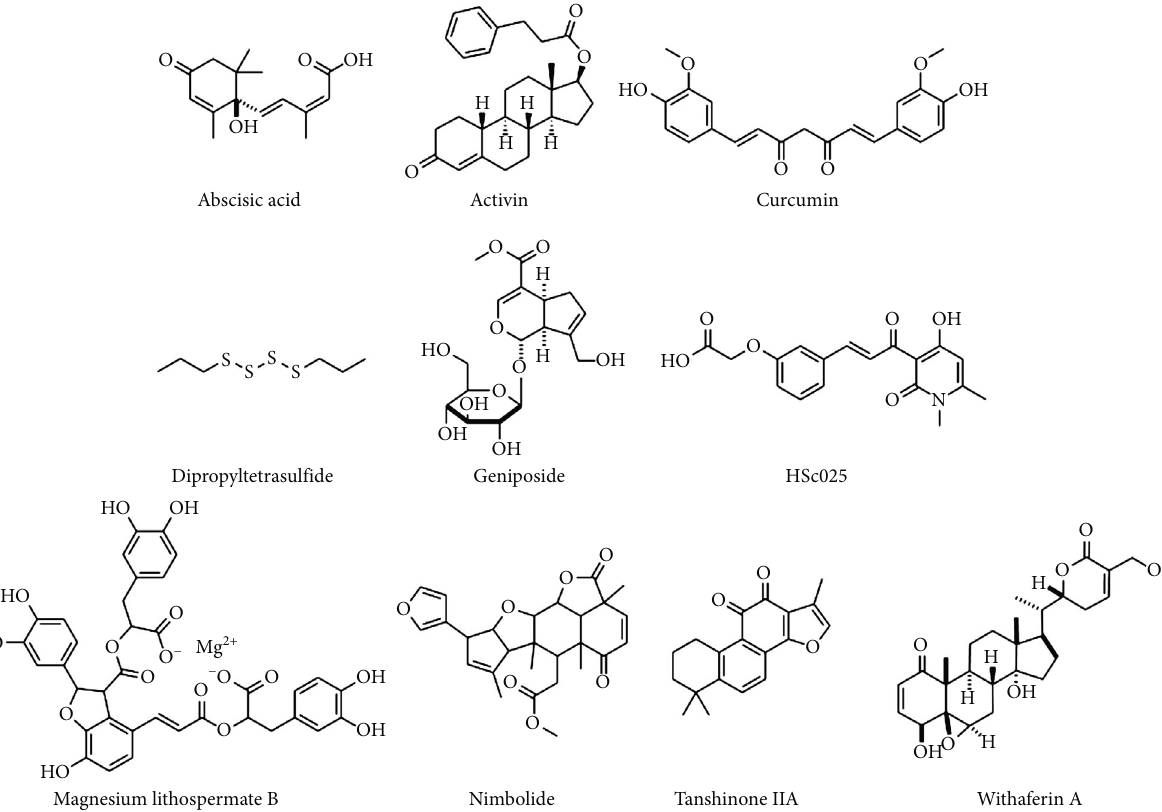
Figure 4: Chemical structures of selected natural product compounds with potential for scleroderma